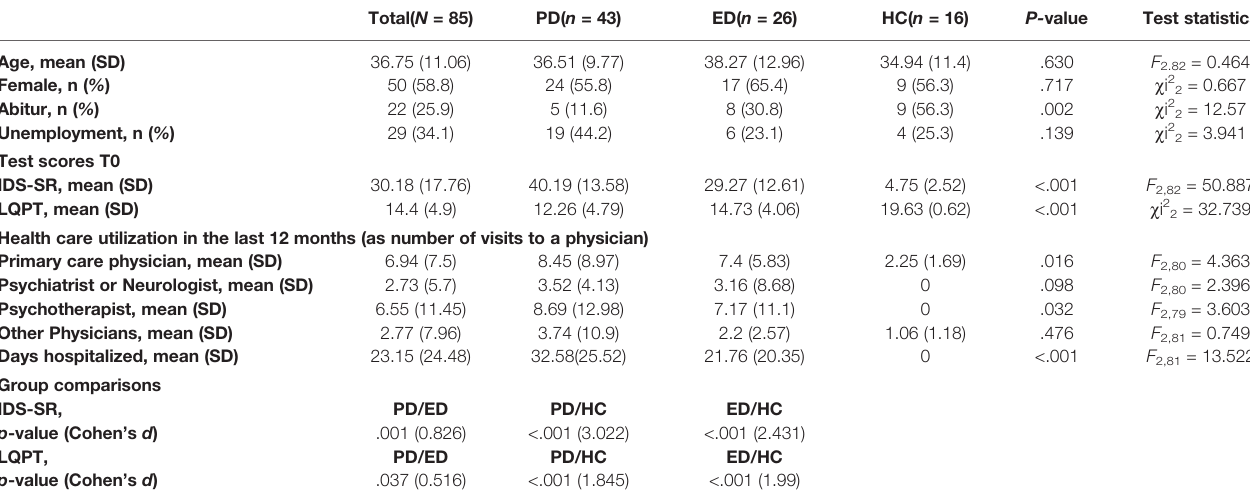
TABLE 1 | Sociodemographic data and Baseline test scores with group